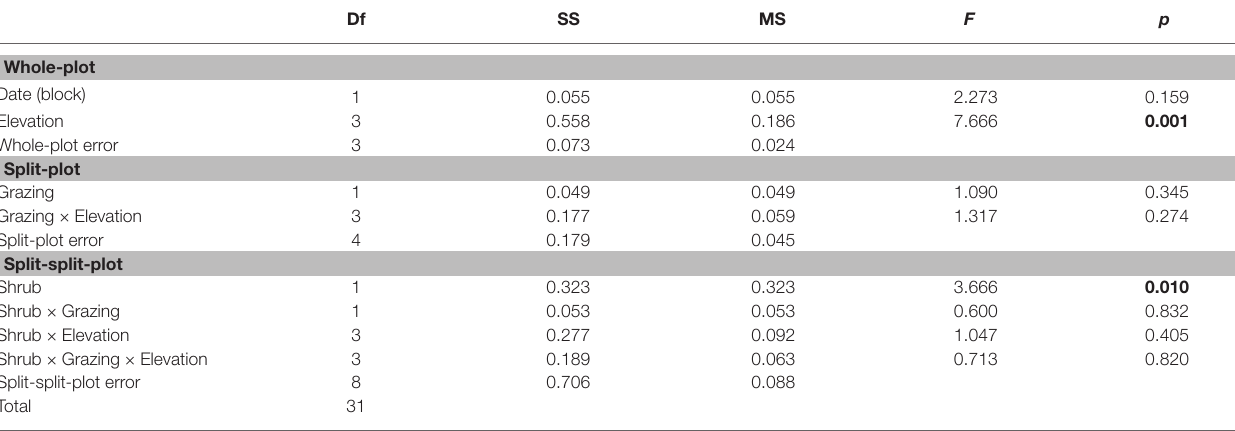
TABLE 2 | Effects of main factors on BSC bacterial community composition under a split-split-plot design.